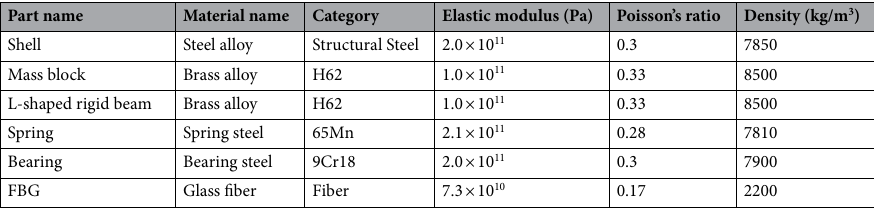
Table 1. Material parameters of the sensor.